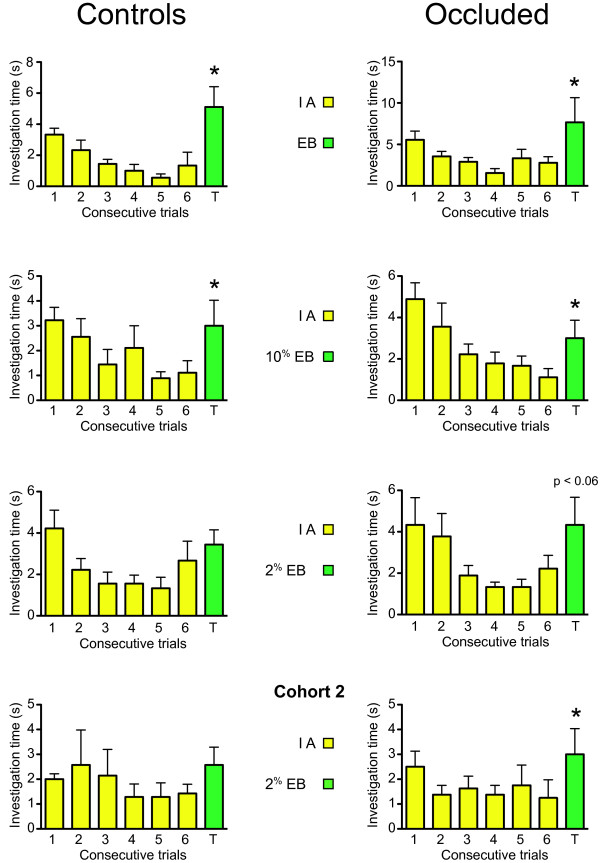
Habituation Results. Mean (± SEM) investigation times for unilateral bulb-x mice during 50 sec habitation (1-6) and dishabituation (T) trials. Data in the left column (controls) are from adult mice that had normal nares (n = 9). Data in the right column (occluded) are from adult mice that received perinatal UNO contralateral to their subsequent adult bulb-x (n = 9). Note that results from the same groups of mice, retested with increasingly diluted test odors, are shown in the first three rows. The fourth row depicts data from a replication of the experiment with a novel cohort of mice (controls n = 7; occluded n = 8). However, only data for the most diluted test odor (2% EB stock in IA stock) is shown. Asterisks denote statistical significance of differences in mean investigation times toward the novel stimulus ("T" = trial seven) compared to habitation stimulus in trial six (paired t-test); * p < 0.05